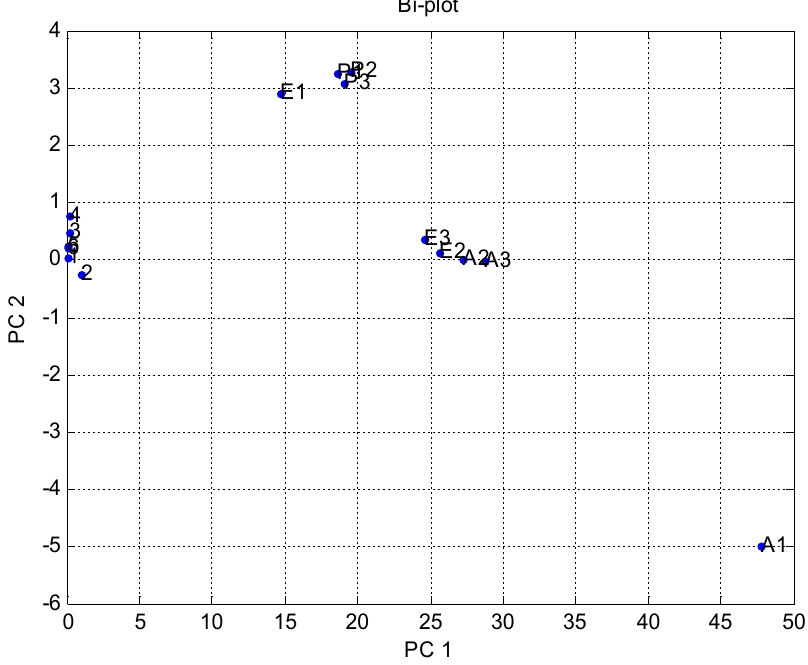
Figure 12. Multivariate technique on organic gases relative feature Bi design.